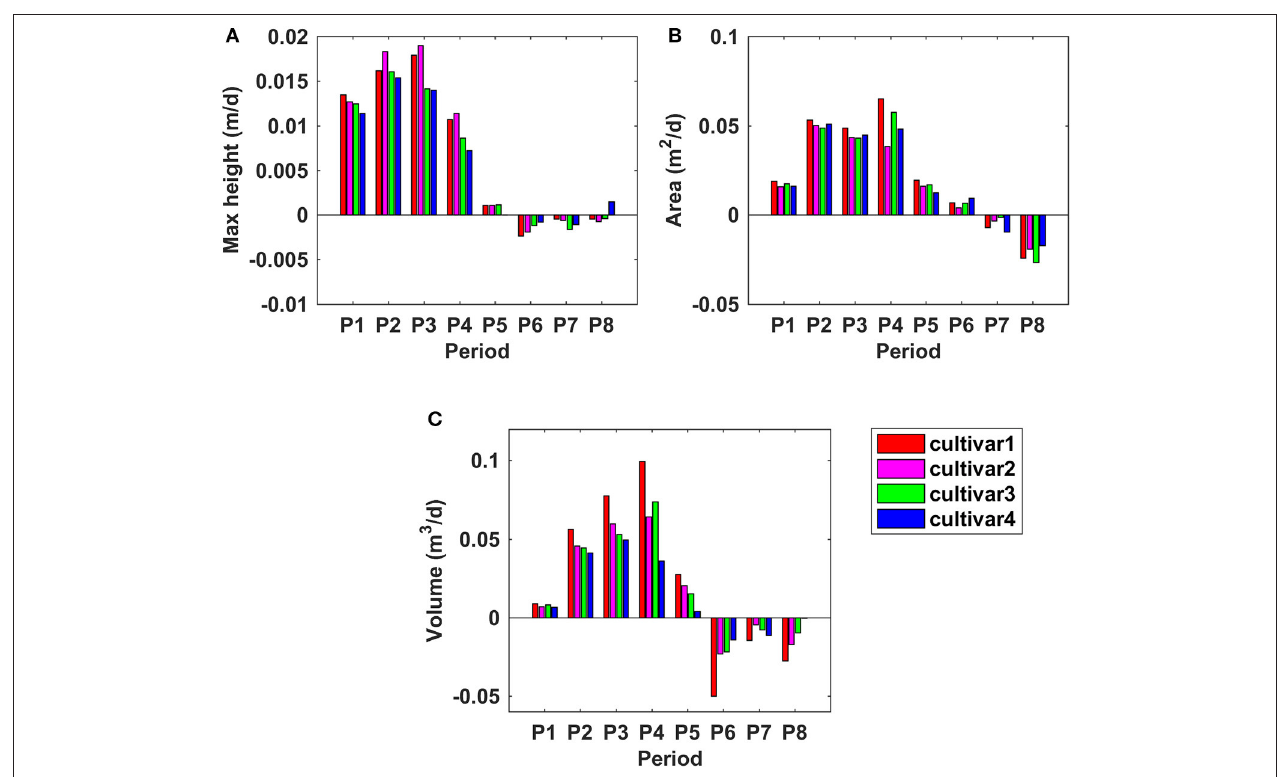
FIGURE 9 | Growth rates for derived morphologic parameters at different time frames during the monitoring period. (A) Maximum canopy height; (B) projected canopy area; (C) plant volume.